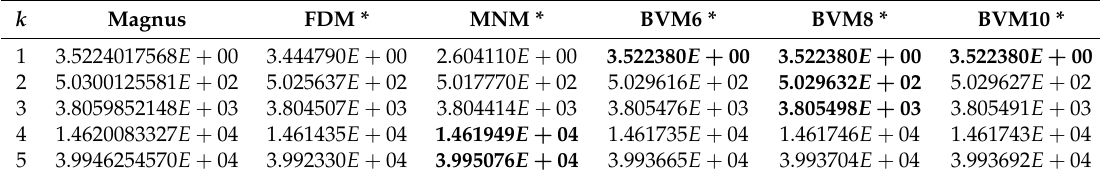
Table 6. The first five eigenvalues of FSLP in Equation (33). * Eigenvalues (except for the Magnus method) were computed using the codes provided by F. Fischer, PhD student at the Potsdam University, Germany. For each eigenvalue computed using Magnus method, the closest ones by other methods are in